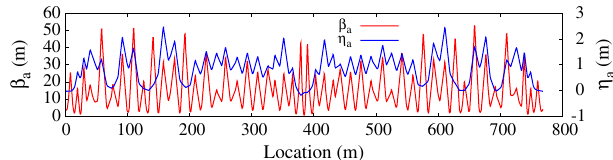
FIG. 10. CesrTA design a -mode (horizontal-like) (cid:4) and dis- persion (cid:2) .